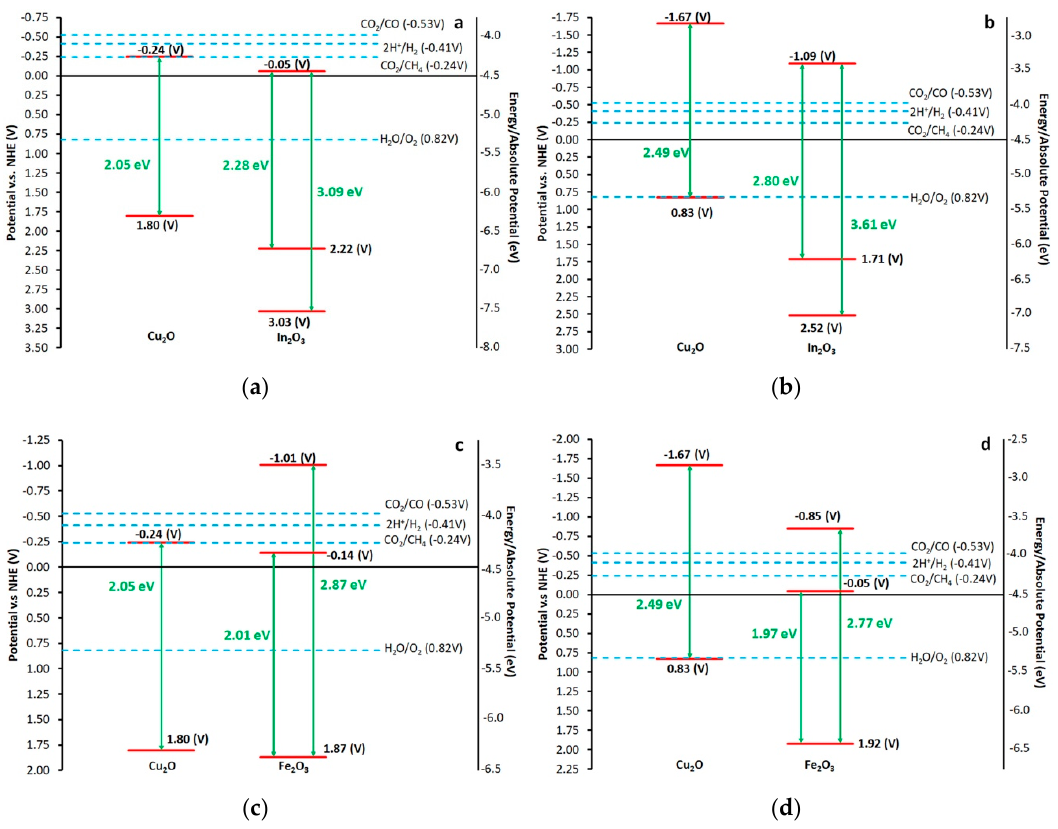
Figure 7. Band structures schemes for Cu 2 O/In 2 O 3 pair, prepared by ( a ) HEM and ( b ) CP, and for Cu 2 O/Fe 2 O 3 pair, prepared by ( c ) HEM and ( d ) CP. Cu 2 O / Fe 2 O 3 pair, prepared by ( c ) HEM and ( d ) CP.